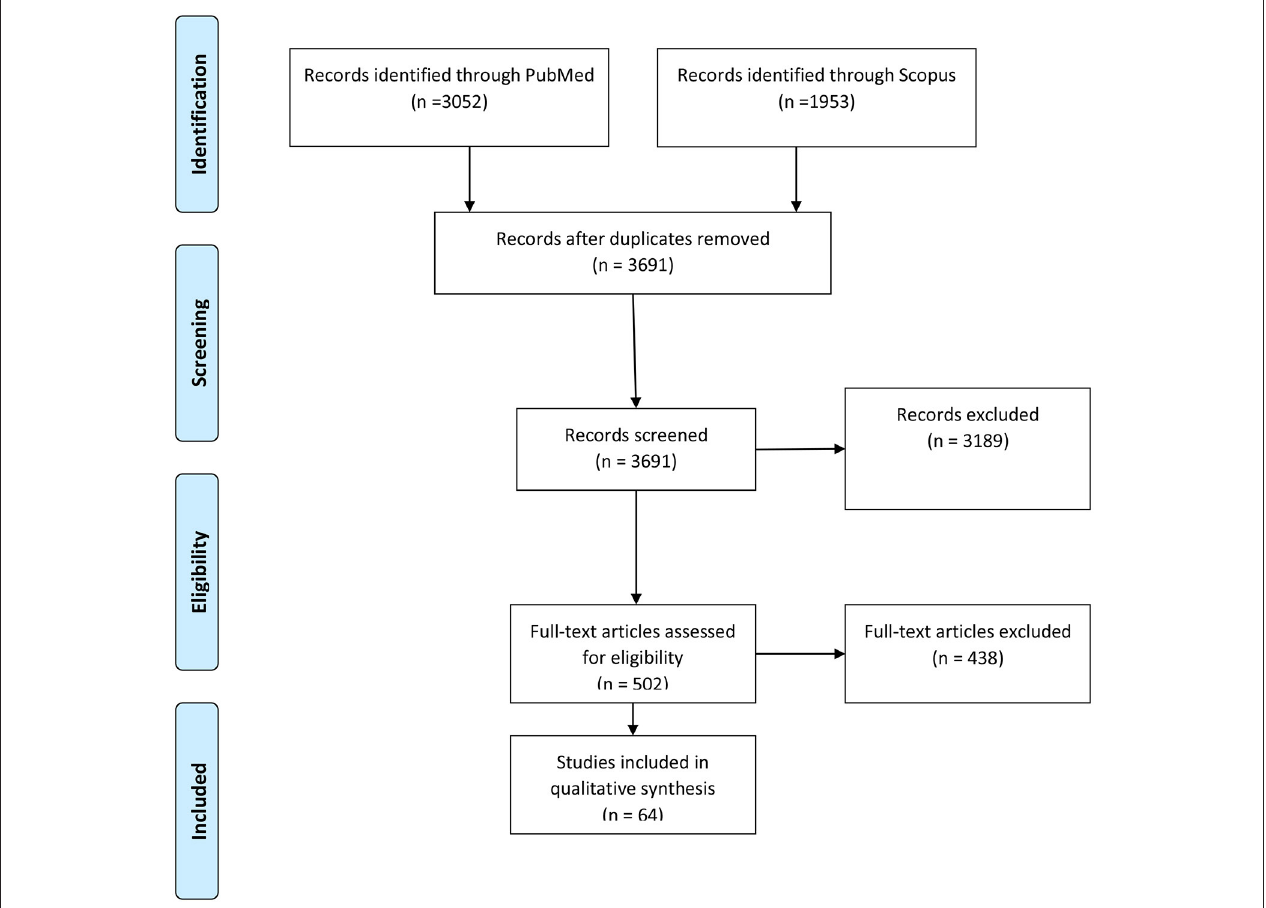
FIGURE 1 | The PRISMA flow diagram of the included studies in the